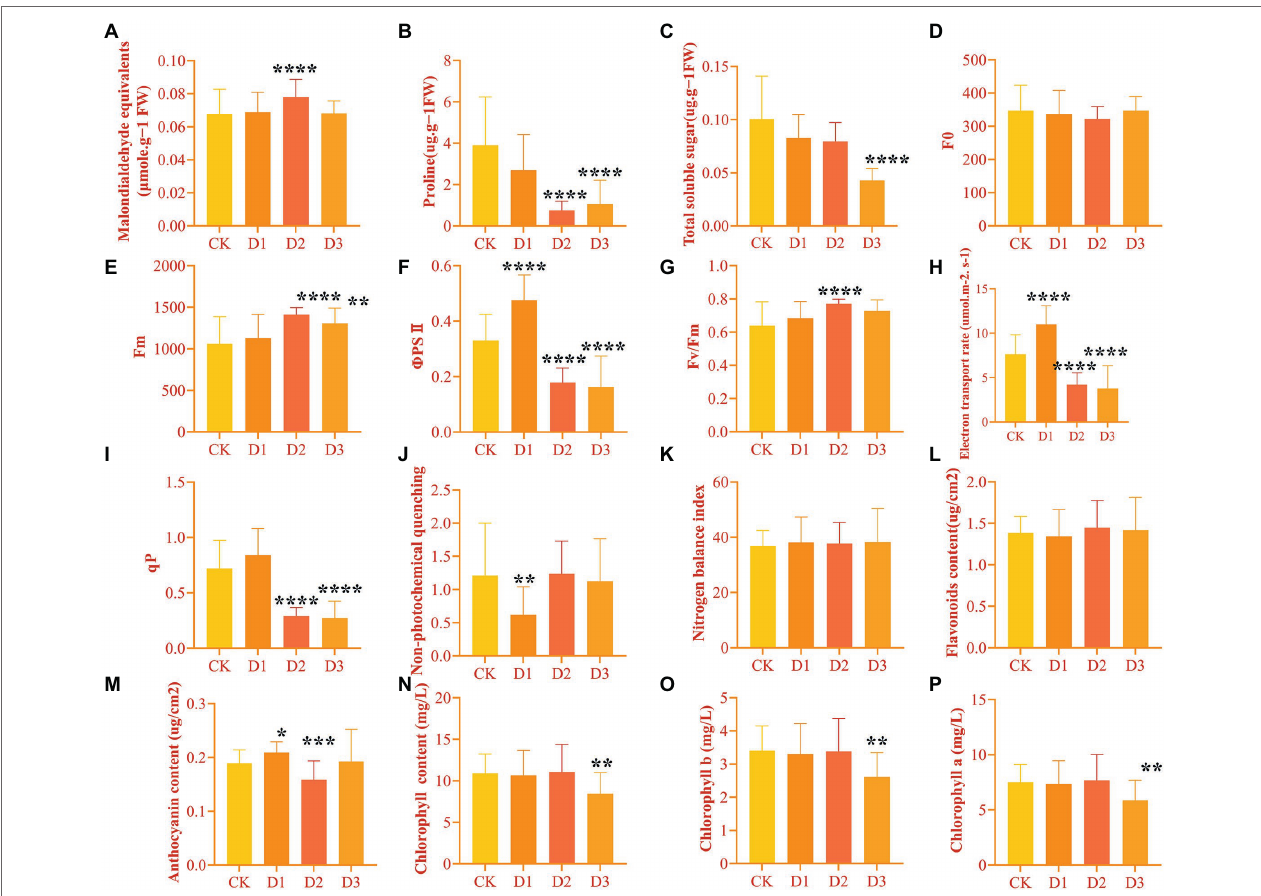
FIGURE 1 | The physiological and biochemical indicators differences under drought treatments were observed by one-way ANOVA analysis in Rhododendron rex . (A) malondialdehyde equivalents (MDA, μ mol ⋅ g − 1 FW); (B) proline (Pro, μ g ⋅ g − 1 FW); (C) total soluble sugar (TSS, μ g ⋅ g − 1 FW); (D) the minimal fluorescence from dark-adapted leaf ( F 0 ); (E) the maximum fluorescence from dark-adapted leaf (Fm); (F) the maximum quantum efficiency of photosystemIIphotochemistry (Fv/Fm); (G) electron transport rate (ETR, μ mol ⋅ m − 2 ⋅ s − 1 ); (H) photochemical quenching coefficient (qP); (I) nonphotochemical quenching (NPQ); (J) nitrogen balance index (NBI); (K) flavoroids (Flv, μ g/cm 2 ); (L) anthocyanin (Anth, μ g/cm 2 ); (M) chlorophyll (Chl, mg/L); (N) chlorophyll b (Chl b , mg/L); (O) chlorophyll a (Chl a , mg/L). The figures were analyzed and visualized by GraphPad Prism (trial version 9.0). The p values were showed by symbol (* p < 0.05; ** p < 0.01; *** p < 0.001; **** p <